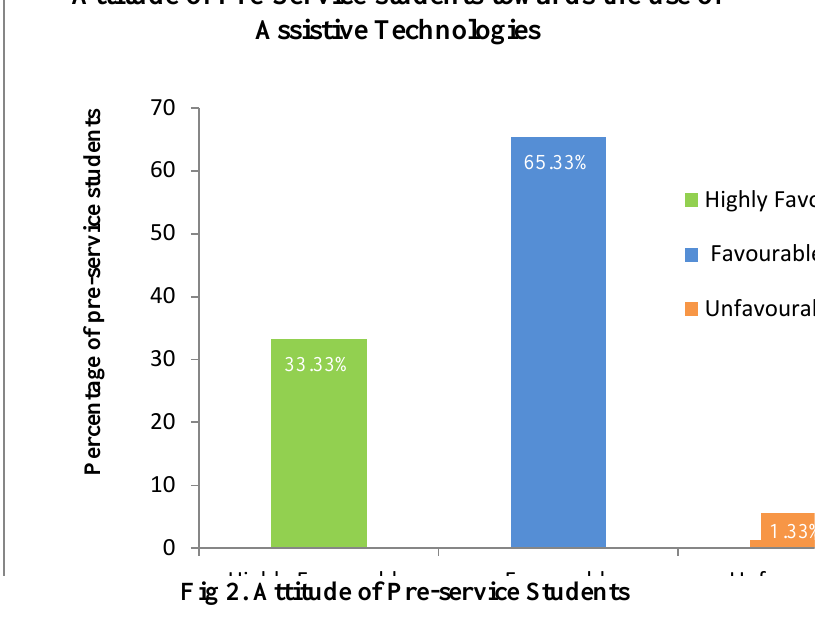
Fig 2. Attitude of Pre-service Students